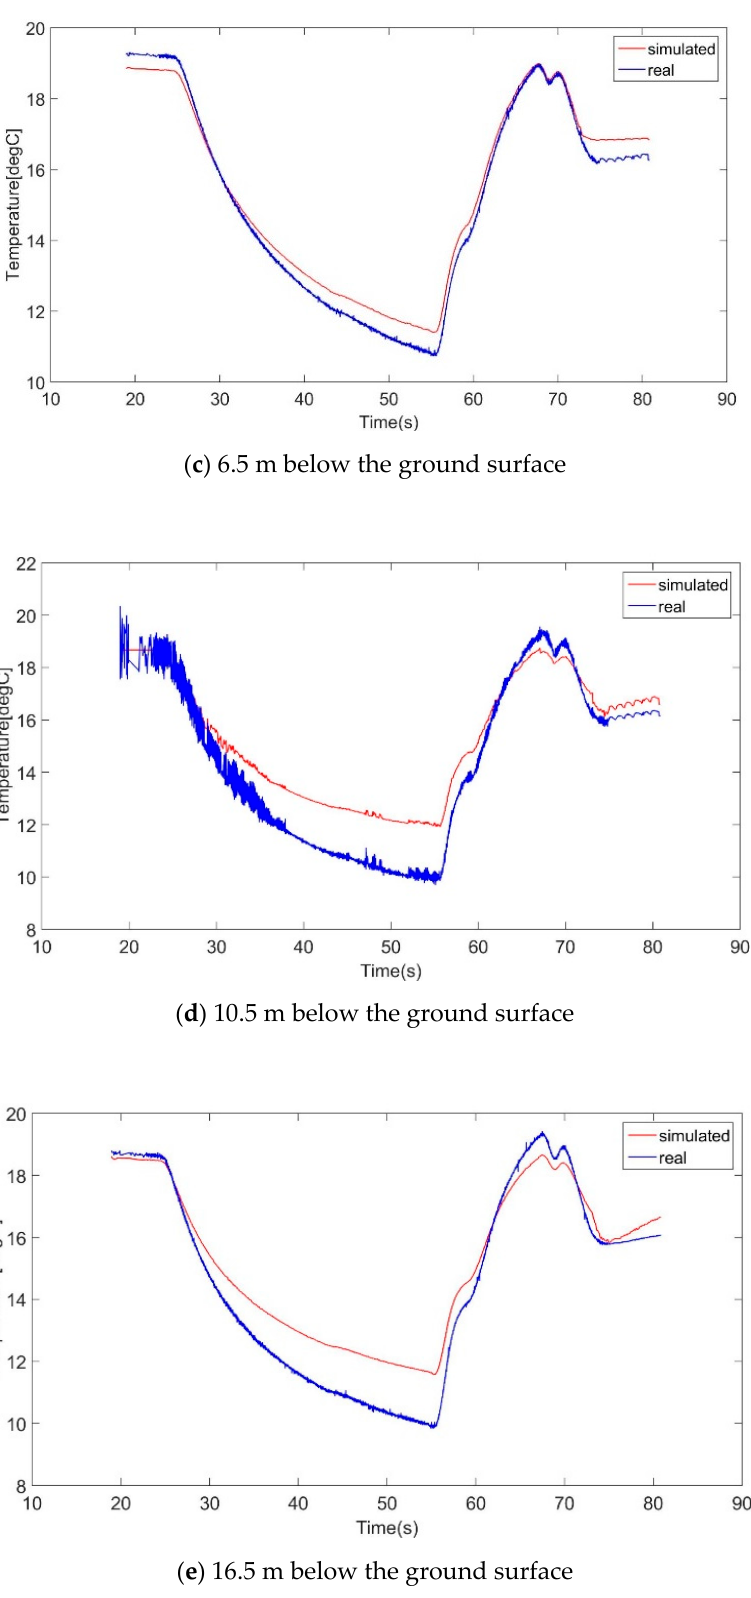
Figure 9. Temperature profiles in the borehole when the heat transfer coefficient across the concrete– soil surface was 3 W/m 2 K.